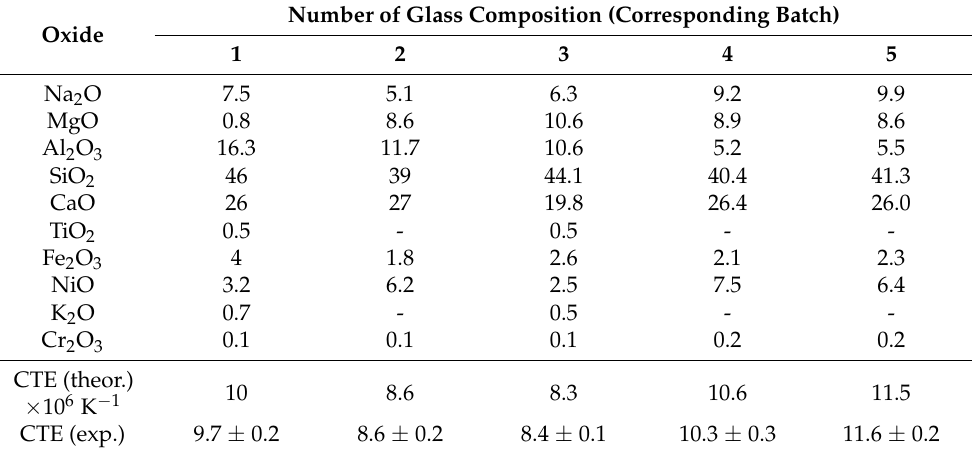
Table 3. Theoretical chemical composition of the glasses based on the formulated raw material mixtures (Table 2) and their calculated (theor.) and measured (exp.) CTE values. Number of Glass Composition (Corresponding Oxide